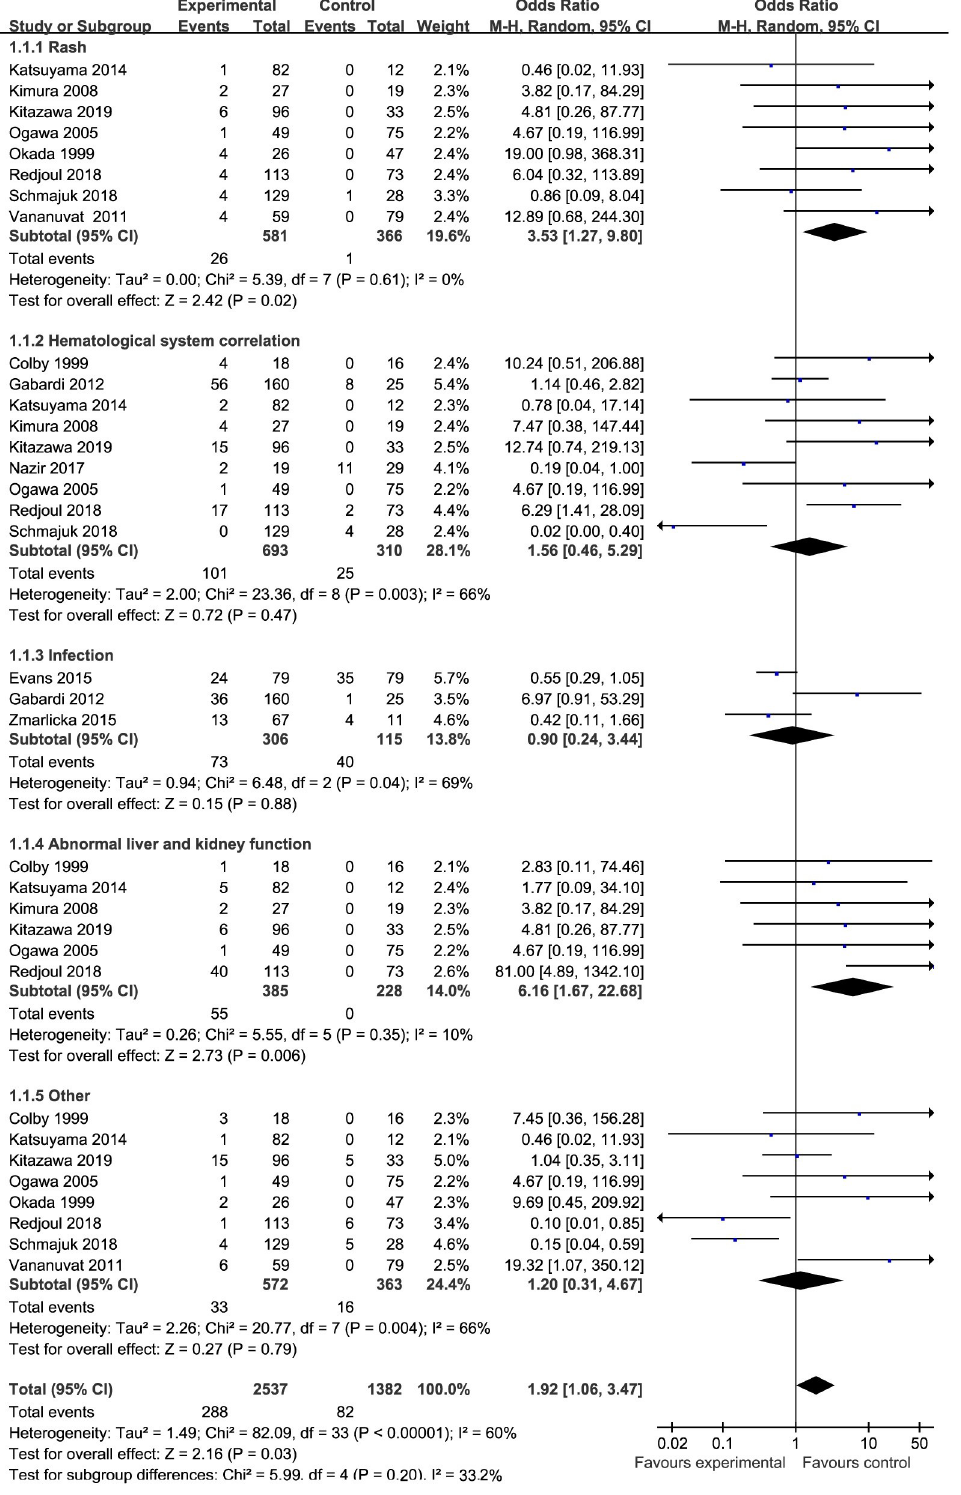
Fig 5. Forest plot of the rate of AEs. The vertical line indicates no difference between the groups. ORs are represented by diamonds, and 95% CIs are depicted by horizontal lines. Squares indicate point estimates, and the size of each square indicates the weight of the given study in the meta-analysis. M-H, Mantel-Haenszel random- effects model.